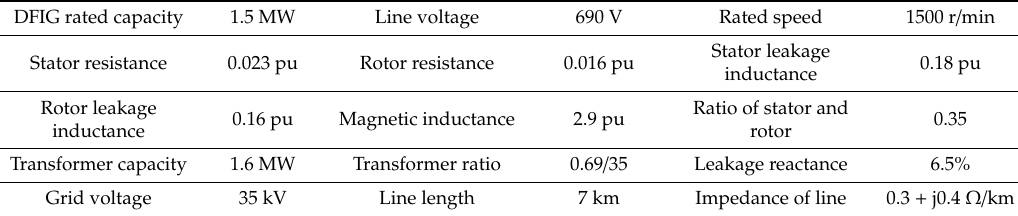
Table 1. Parameters of the simulation model.